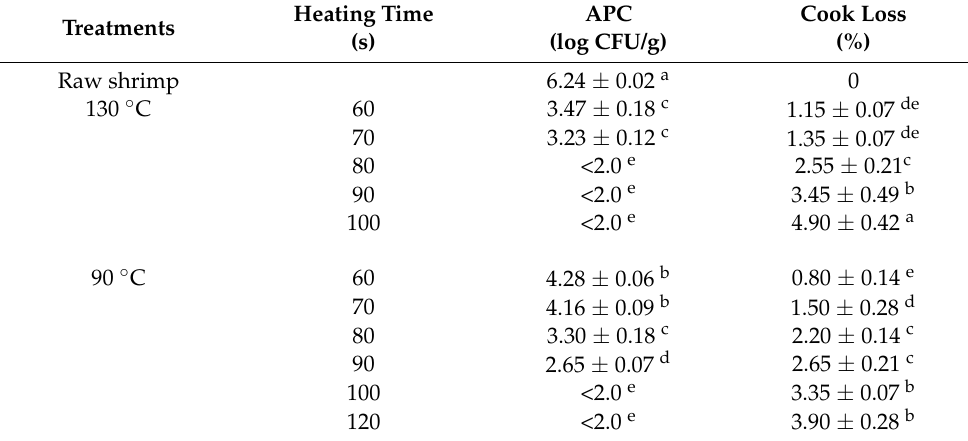
Table 2. Changes in aerobic plate count (APC) and cook loss in white shrimp using microwave-assisted induction heating (MAIH) system set at 130 and 90°C for different heating times.